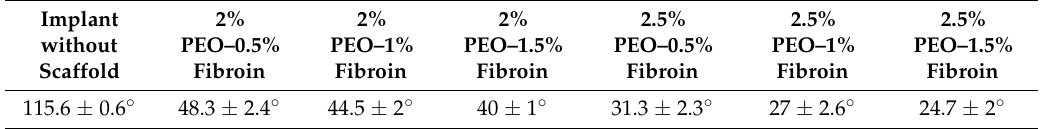
Table 2. Contact angle of the PEO–fibroin scaffolds and a breast implant